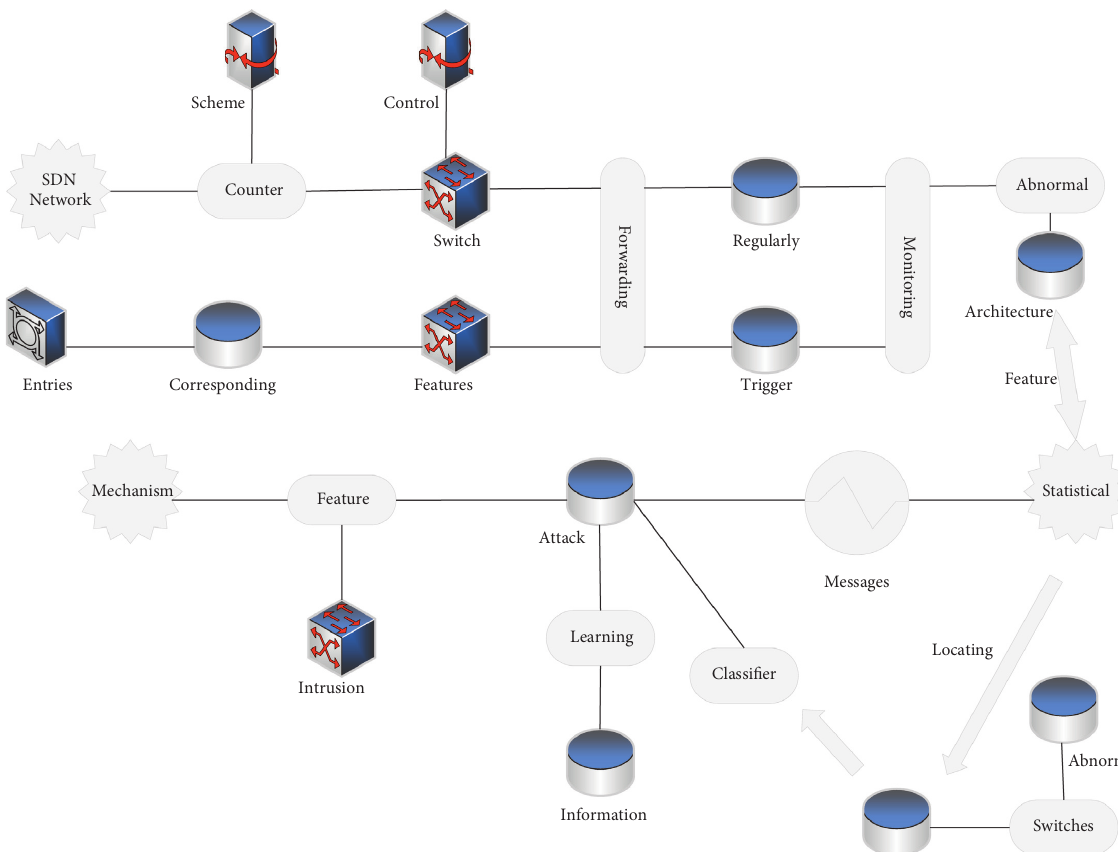
Figure 4: Flow chart of the detection